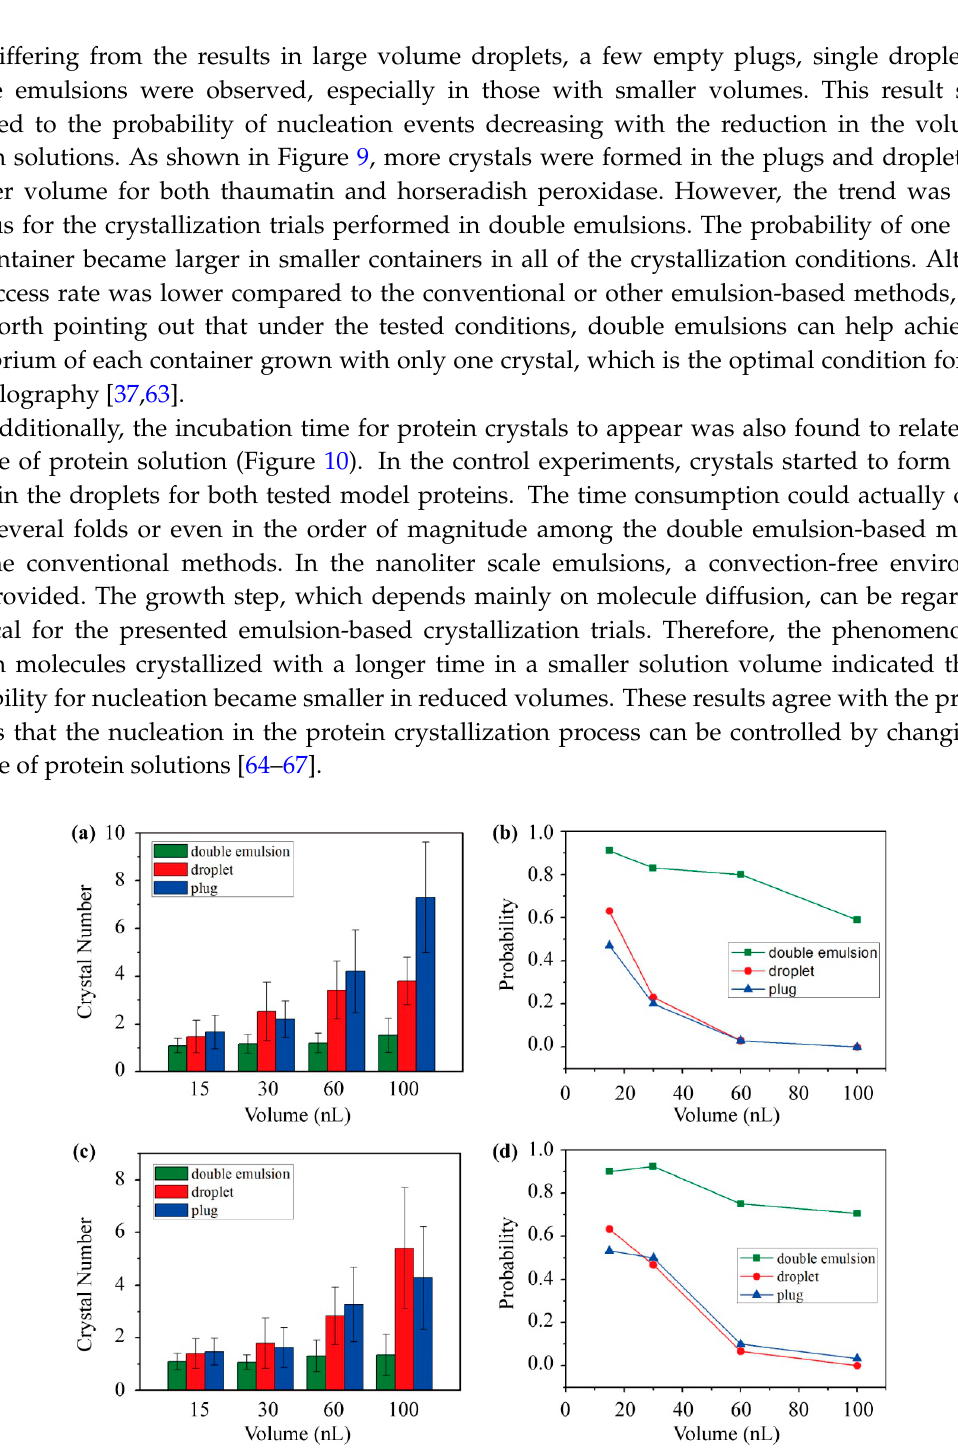
Figure 10. Plot of the incubation time for the protein crystals to appear in double emulsions with different protein solution volumes for ( a ) thaumatin and ( b ) horseradish peroxidase. The model proteins: 20 mg/mL thaumatin and 5 mg/mL horseradish peroxidase. 3.7. Double Emulsion-Based Approach for Sparse Matrix Screening To perform sparse matrix screening by the double emulsion-based approach, the solutions of the crystallization screening kit were firstly preloaded into a piece of Teflon tubing in the form of segments, all of which were separated with fluorocarbon oil and air plugs. The reagent consumption of the protein crystallization screening kit was as small as several microliters for each. To avoid the instability of solution plugs where air bubbles might be trapped unexpectedly in single long Teflon tubing, the screening kit solutions were divided into a few groups and preloaded into several pieces of Teflon tubing within a proper length (<15 cm). The Teflon tubing between the syringe and the plastic-glass hybrid microfluidic device can be replaced with another containing different screening kit solutions to facilitate a high-throughput sparse matrix screening without affecting the performance. The protein crystallization screening kit used here was Crystal Screen HT™-HR2-130 from Hampton Research (Laguna Niguel, CA, USA), containing 72 screening conditions. The model protein was 20 mg/mL thaumatin, which would be mixed with the screening kit solutions at an equal volume ratio. The double emulsion-based microbatch method was performed for the screening trials